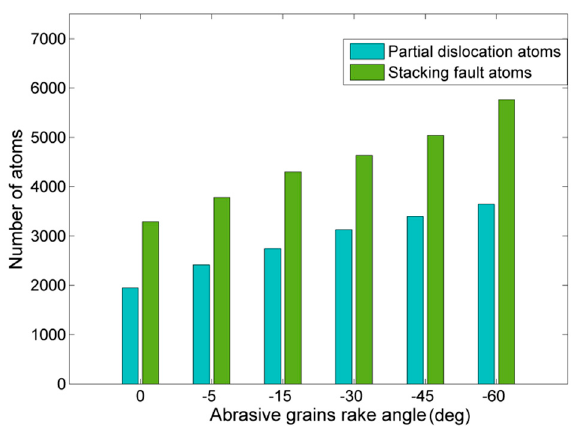
Figure 10. Number of atoms pertinent to partial dislocations and stacking faults in respect to abrasive grains rake angle.